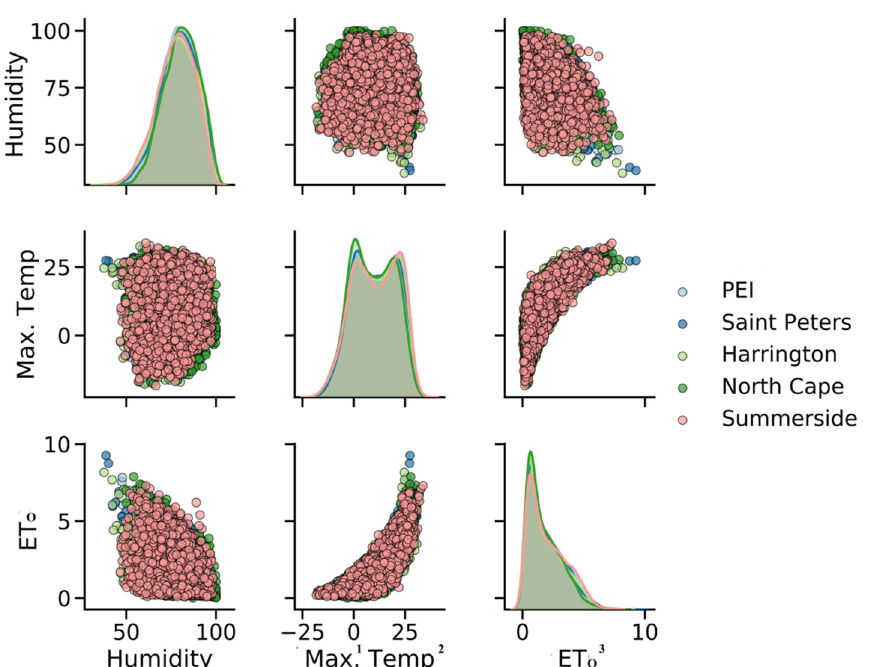
Figure 4. Pair plots of selected variables for year 2011–2017. Where 1 Max. Temp is Maximum air temperature; 2 ETo is reference evapotranspiration computed from the FAO-56 method.